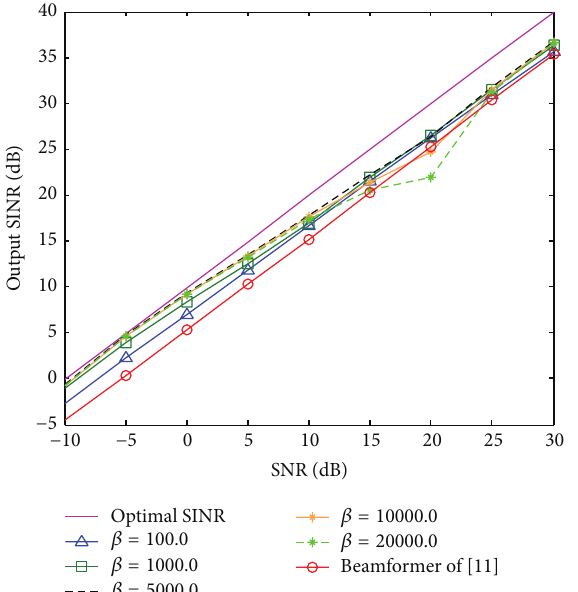
Figure 16: Output SINR versus the input SNR with different 𝛽 (INR = 20dB).